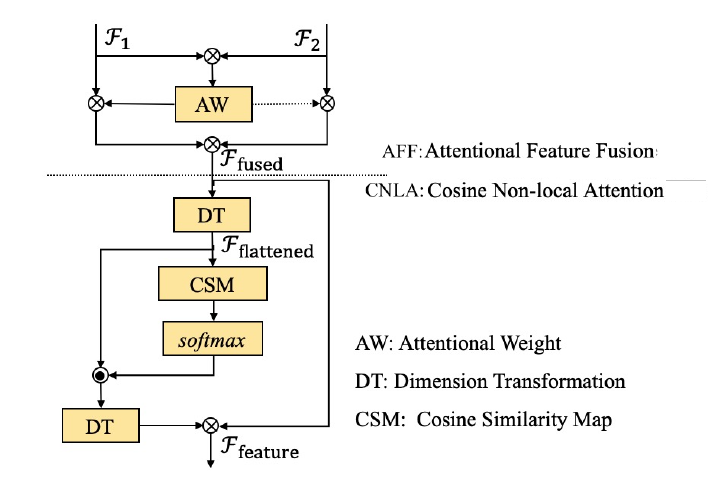
Figure 5. AFF-embedded CNLA